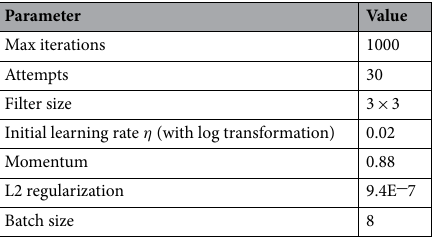
Table 1. Parameter setting for CNN.